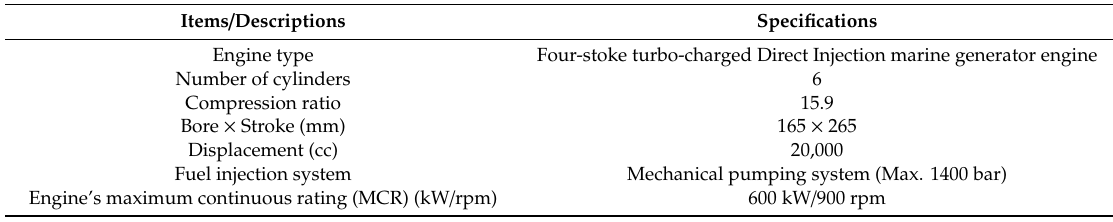
Table 2. Specifications for test engine.